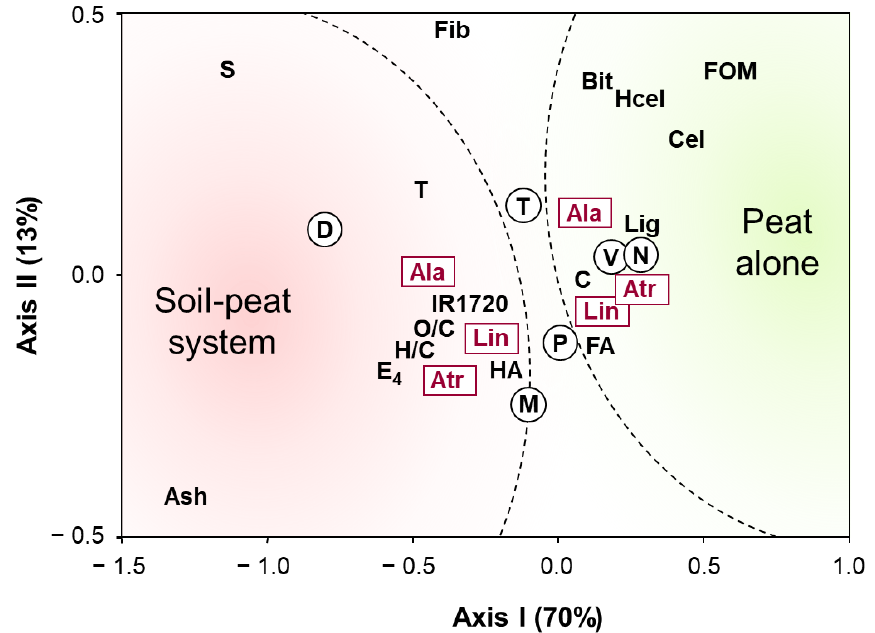
Figure 2. Correspondence analysis showing the influence of several analytical characteristics of peats on the herbicide sorption (labels in boxes) in two different systems: peat alone and peat-treated soil. Encircled labels correspond to peat samples: D = Daimiel; M = Mazagón; N = Neuhaus; P = Padul; T = Torreblanca; V = Vivero. Variables corresponding to herbicide sorption are indicated in squared boxes: Ala = alachlor; Atr = atrazine; Lin = linuron. Bold labels represent other peat variables: Ash = total ash (g 100 g –1 ); Bit = total bitumen (g 100 g –1 peat); C = organic C (g 100 g –1 ); Cel = cellulose (g 100 g –1 peat); E4 = optical density at 465 nm in humic acid (AU); FA = fulvic acid (g 100 g –1 peat); Fib = total fibers (g 100 g –1 ); FOM = free organic matter (g 100 g –1 ); H/C = H/C atomic ratio in humic acid; HA = humic acid (g 100 g –1 peat); Hcel = hemicellulose (g 100 g –1 peat); IR1720 = 1720/2920 cm −1 intensity ratio in the IR spectra from humic acid; Lig = residue (g 100 g –1 peat); O/C = O/C atomic ratio in humic acid; S = total bases (cmol c kg –1 ); T = Total exchange capacity (cmol c kg –1 ). The percentage of the total variance accounted for by the two first components is shown in the axes.